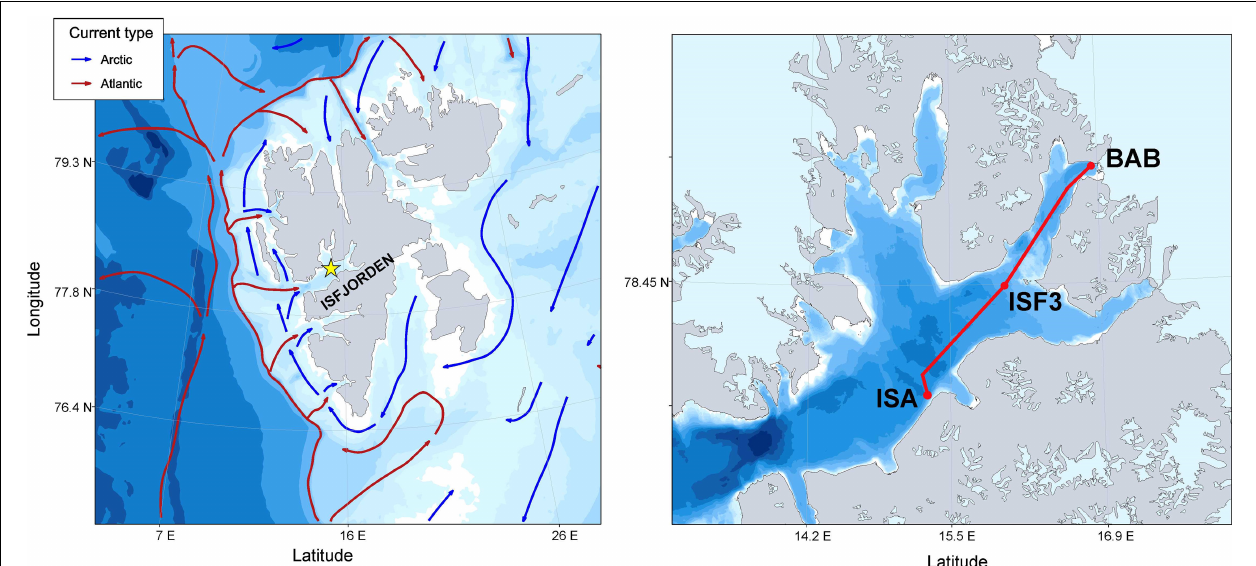
FIGURE 1 | Study area: Map of Svalbard Archipelago with schematic ocean currents circulation (PlotSvalbard R package by Vihtakari (2019); transect of laser-based measurements (LOPC & LISST marked as a red line) and plankton stations (ISA, ISF3 and BAB marked as red dots) in